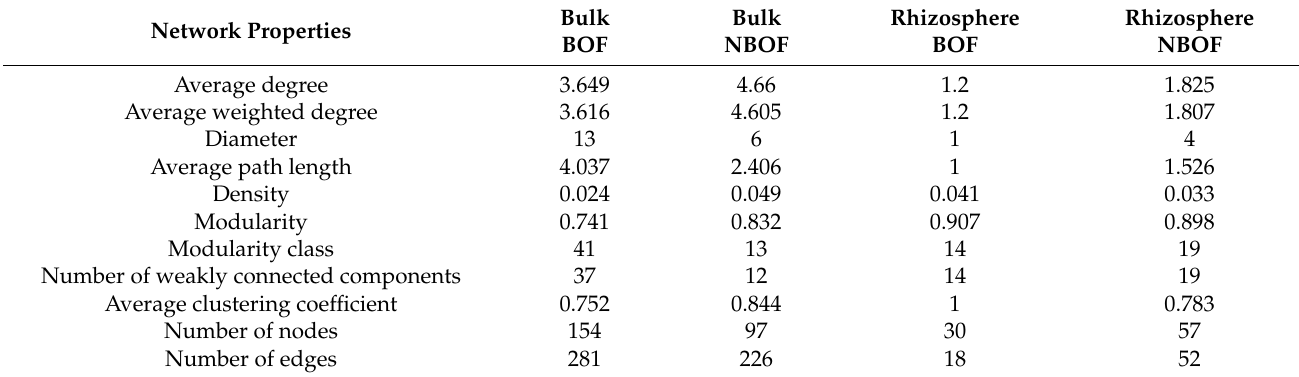
Table 4. The bacterial co-occurrence network properties.